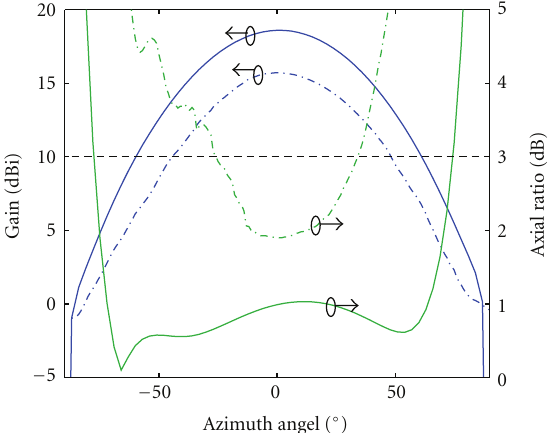
Figure 5: Simulated (full line) and measured (dashed-dotted line) gain pattern in the azimuth plane, that is, the XY -plane (Figure 2), for an array with main lobe steered along 0 ◦ .